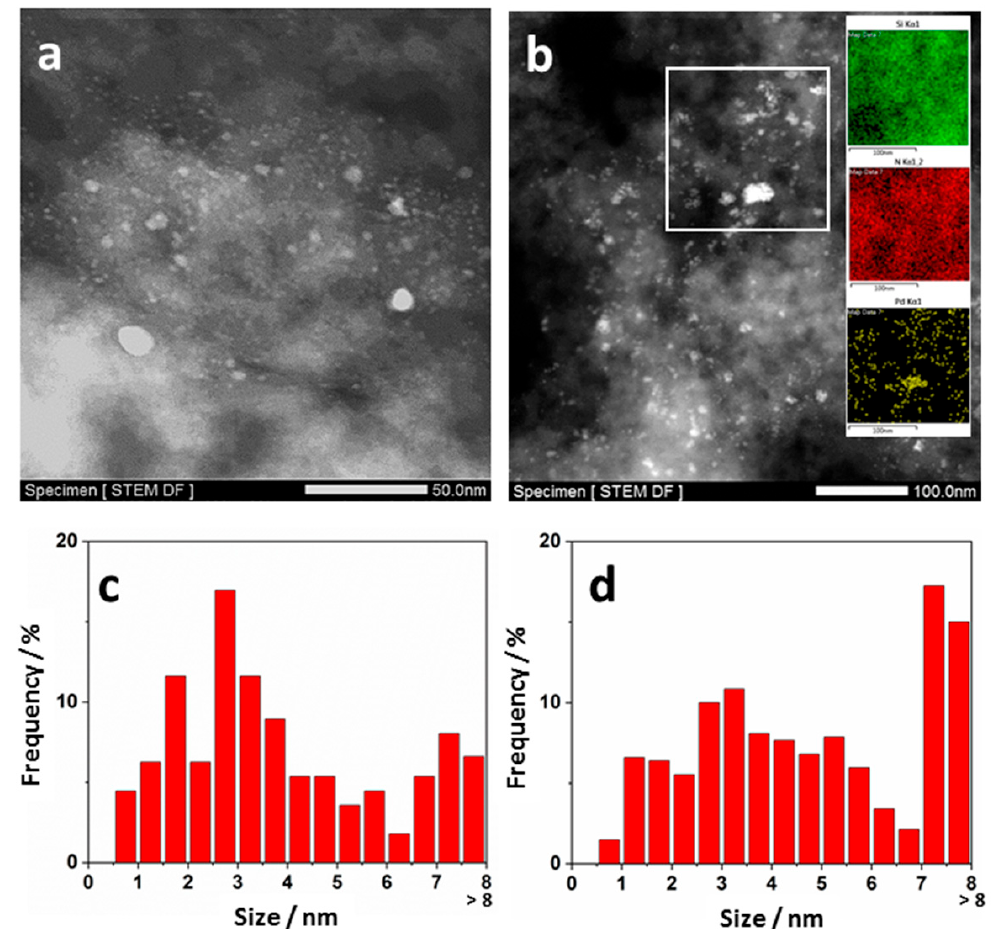
Figure 4. ( a ) HAADF-STEM image of the Pd NPs-UVM-7/PDA- 4 catalyst. ( b ) HAADF-STEM image of the Pd NPs-UVM-7/PDA- 5 catalyst including an EDX mapping of the selected area showing the Si, N, and Pd distribution. ( c ) Histogram showing the Pd NPs size distribution in the Pd NPs-UVM-7/PDA- 4 catalyst. ( d ) Histogram showing the Pd NPs size distribution in the Pd NPs-UVM-7/PDA- 5 catalyst.